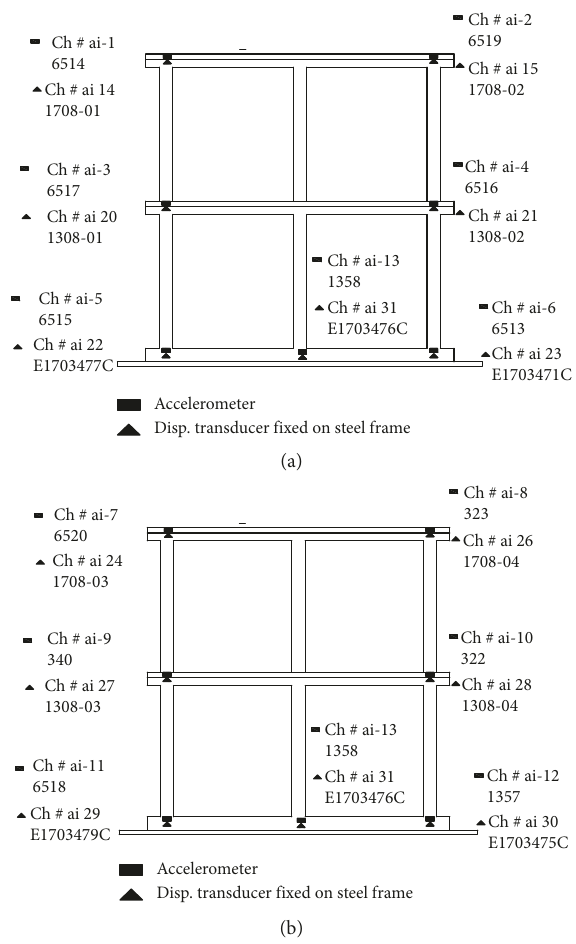
Figure 11: Instrumentation setup. (a) North face instrumentation.